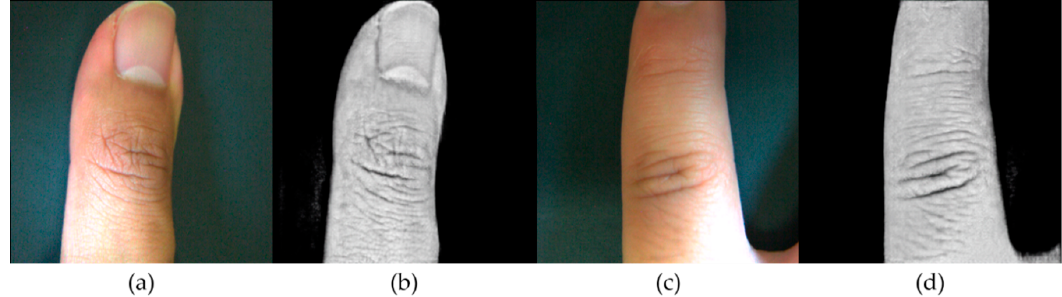
Figure 4. The original images taken from a Lytro camera with directional illumination and corresponding output images obtained from CGAN model: ( a , c ) show the center images of Lytro camera images taken under directional illumination; ( b , d ) represent the output images obtained from our CGAN model.